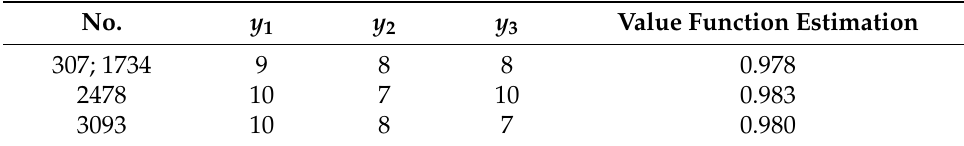
Table 5. The remaining non-dominated vector scores.